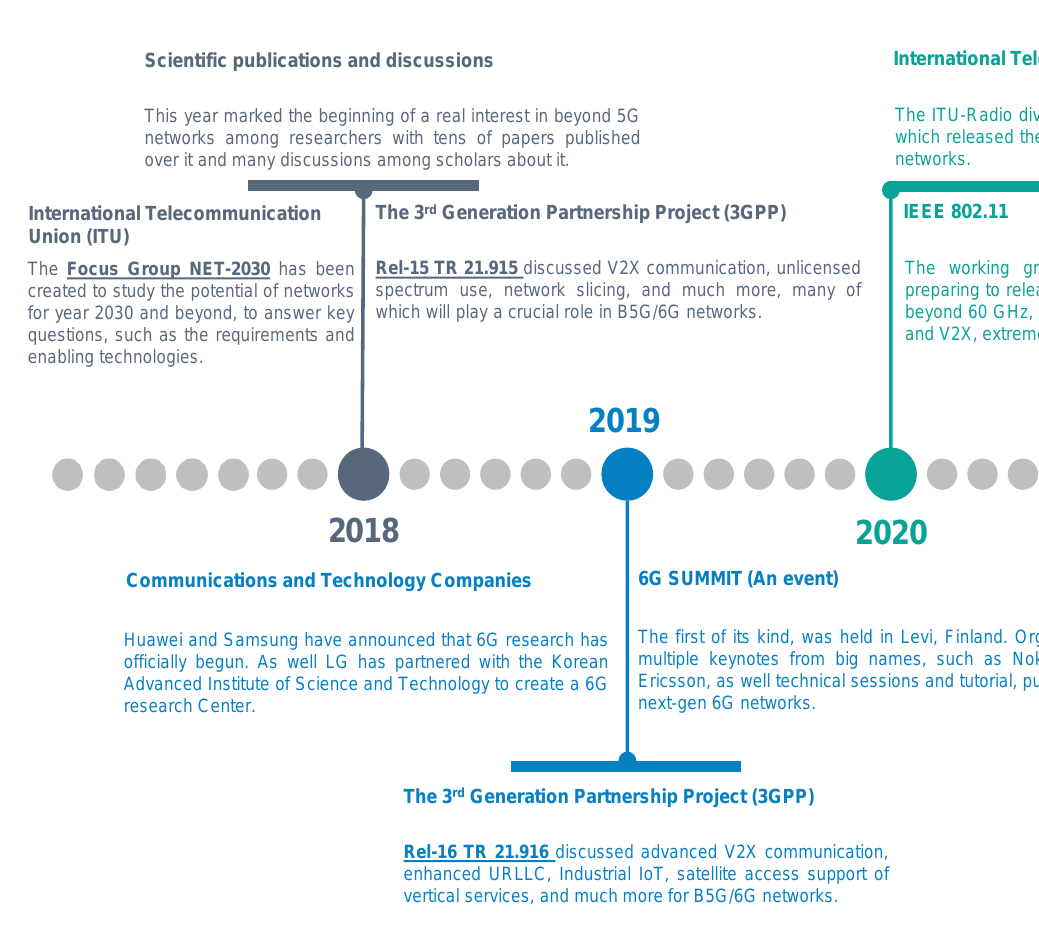
Figure 8. The envisioned timeline for